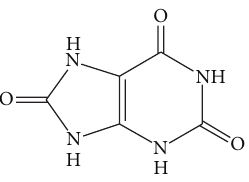
Figure 1: Chemical structure of